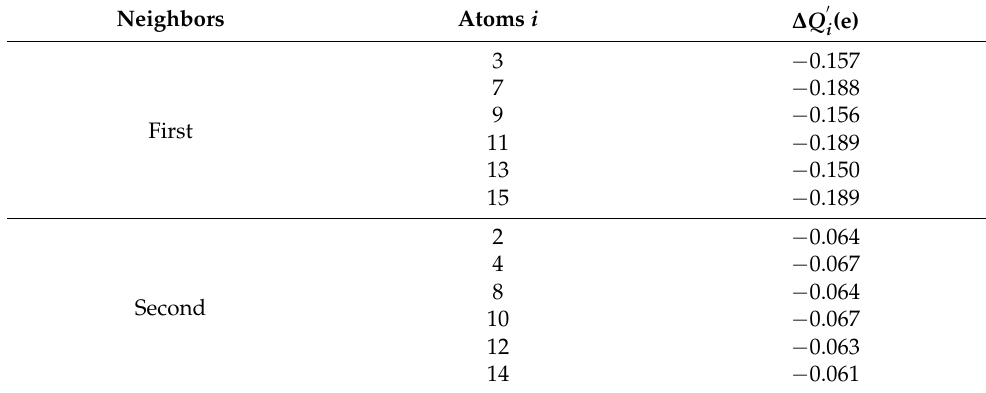
Table 4. Changes in the Bader charge at the T–MnO 2 /graphene-V Mn